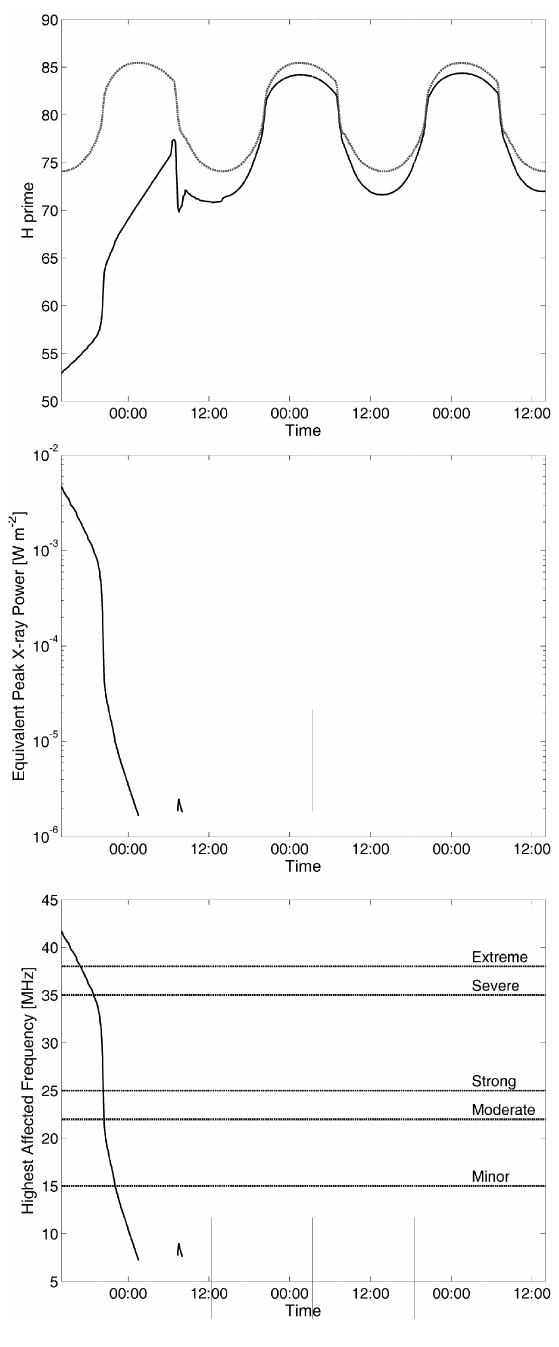
Fig. 11. Estimate of the severity of the RBR-forced HF blackout for the case shown in Fig. 5. The upper panel indicates the change in the Wait ionosphere H 0 parameter for the forced (heavy line) and unforced (light line) cases. The middle panel shows the equivalent peak X-ray power in the 0.1–0.8nm range which would cause the same H 0 during a solar flare. The lower panel is the Highest Af- fected Frequency calculated from the equivalent peak X-ray power. The NOAA Radio Blackout Scale has been added for comparison.